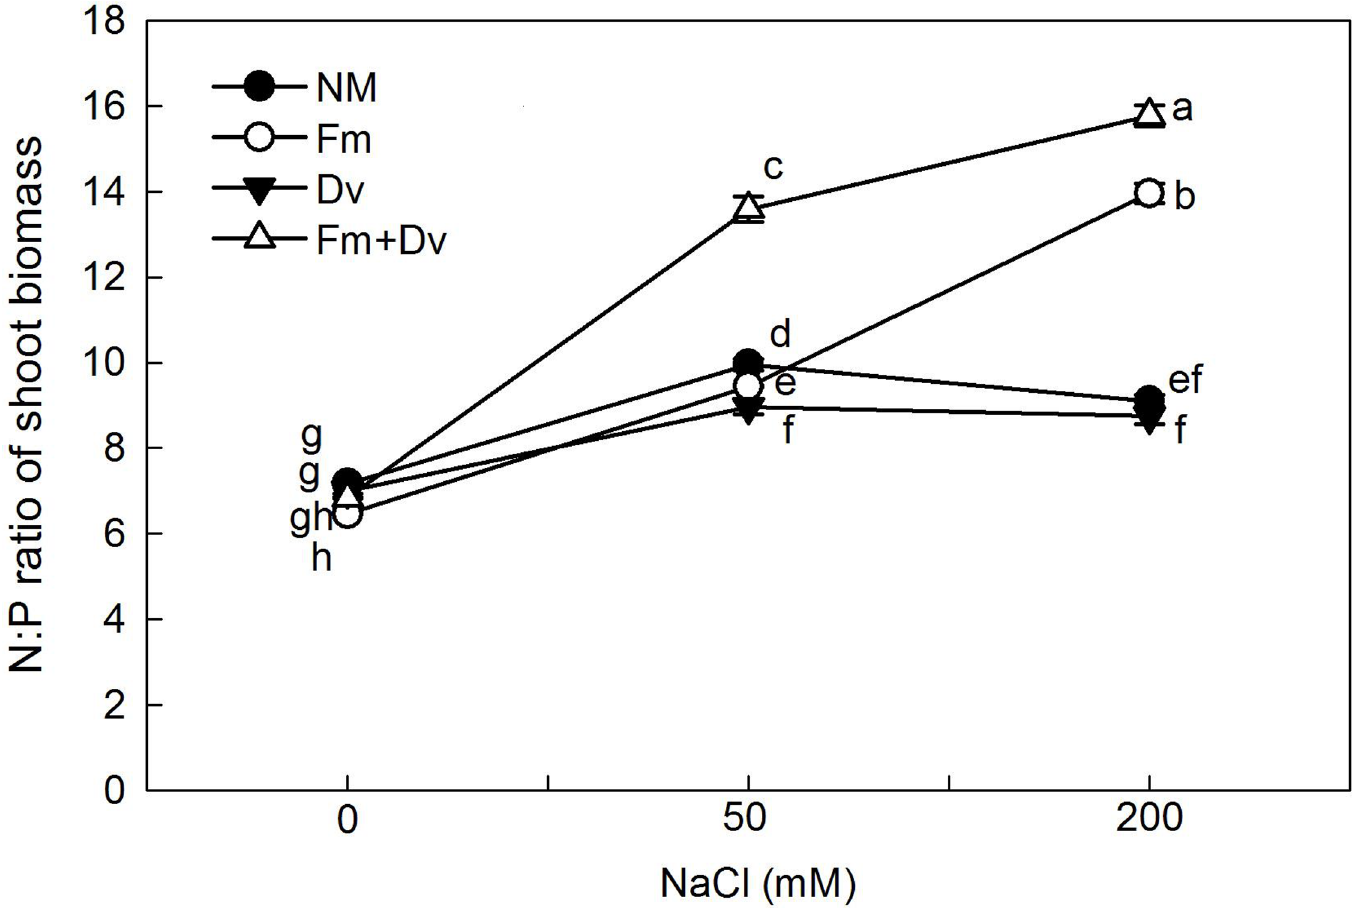
Fig 5. Effects of arbuscular mycorrhizal fungi on the N:P ratio of Chrysanthemum morifolium plants under 0, 50 and 200 mM NaCl. Symbols are the same as in Fig 1.